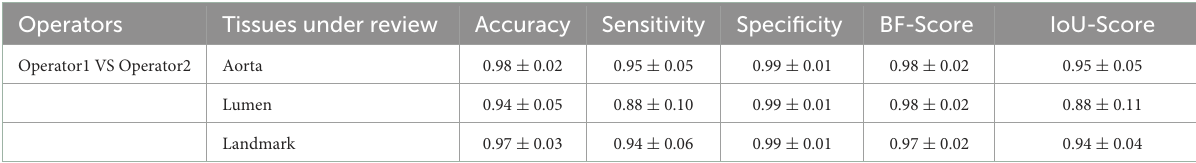
TABLE 8 Inter-operator variability by comparison the segmentation masks created by two expert